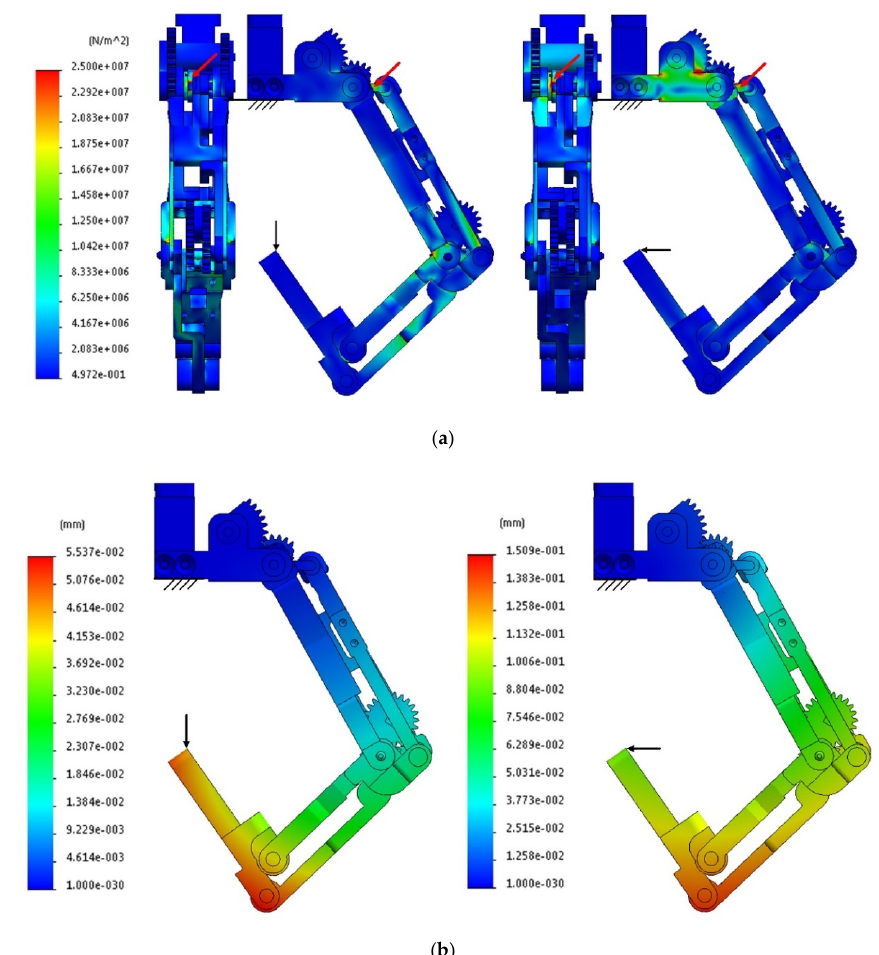
Figure 6. (a) Stress distributions and (b) deflections in the finger module when external forces are 216 Figure 6. ( a ) Stress distributions and ( b ) deflections in the finger module when external forces are applied along the (cid:1877) - (left) and (cid:1876) -coordinate axes (right) at the fingertip. 217 applied along the y - (left) and x -coordinate axes (right) at the